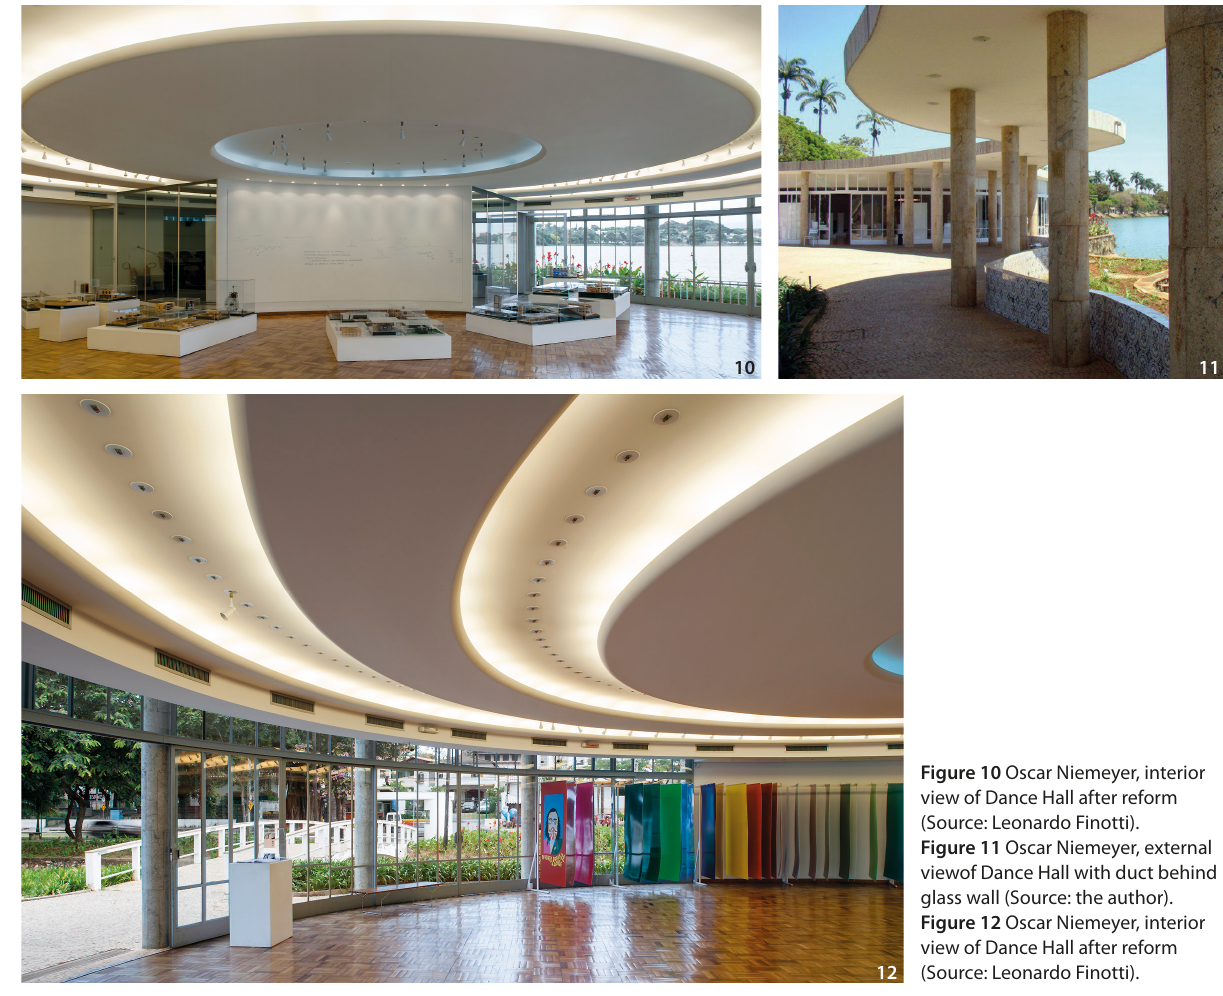
Figure 10 Oscar Niemeyer, interior view of Dance Hall after reform (Source: Leonardo Finotti). Figure 11 Oscar Niemeyer, external viewof Dance Hall with duct behind glass wall (Source: the author). Figure 12 Oscar Niemeyer, interior view of Dance Hall after reform (Source: Leonardo